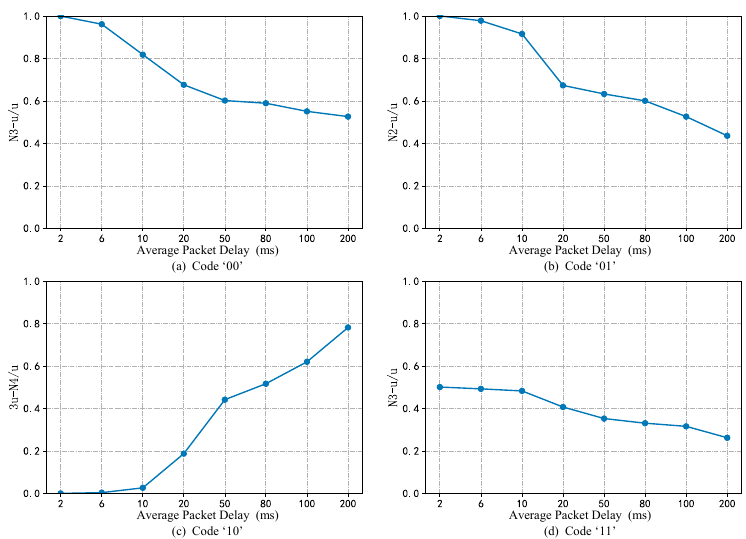
Figure 11. The Crps in different packet delays in Figure 7a.